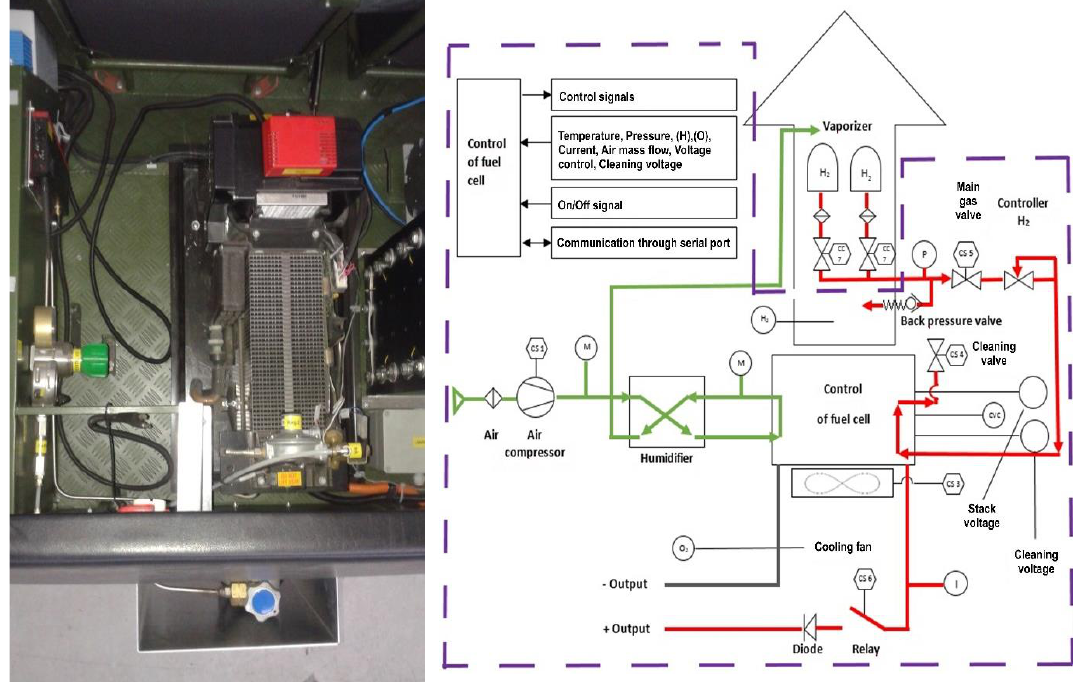
Figure 1. Hydrogen propulsion of an experimental vehicle and schematic representation of its component.